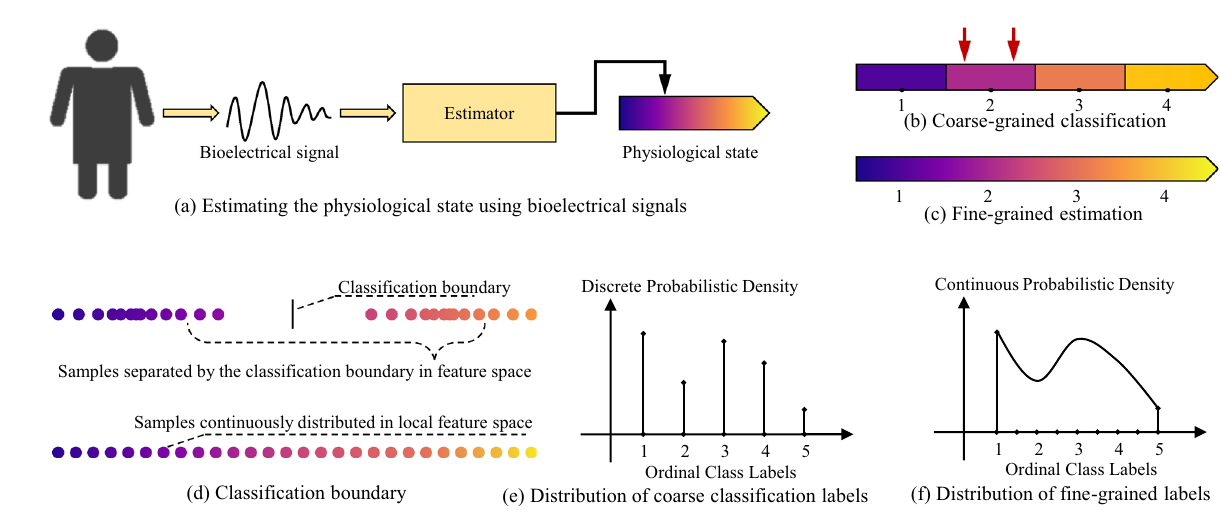
Figure 1. Overview. The basic objective is to estimate the intrinsic physiological state of subjects from their bioelectrical signals, illustrated in ( a ). ( b ) Shows an example of coarse labels, where the red arrows point to different states but have the same label. The inaccuracy is caused by quantizing the continuous physiological state ( c ) into discrete stages in ( b ). Although imprecise, the coarse labels are easy to obtain and abundant in quantity. The final objective is to offer a precise estimate of the real physiological state by learning from those coarse labels. ( d ) Compares the typical classification and the proposed fine-grained assessment. Classifiers tend to build boundaries in feature space, while there should be no absolute boundary between neighboring physiological states. ( e ) Shows an example distribution of discrete classification labels suffering from inaccuracy in describing continuous physiological states. ( f ) Presents the approximated distribution of continuous fine- grained labels, which is restored from ( e ) via interpolation by assuming the ordinal and continuous nature of physiological